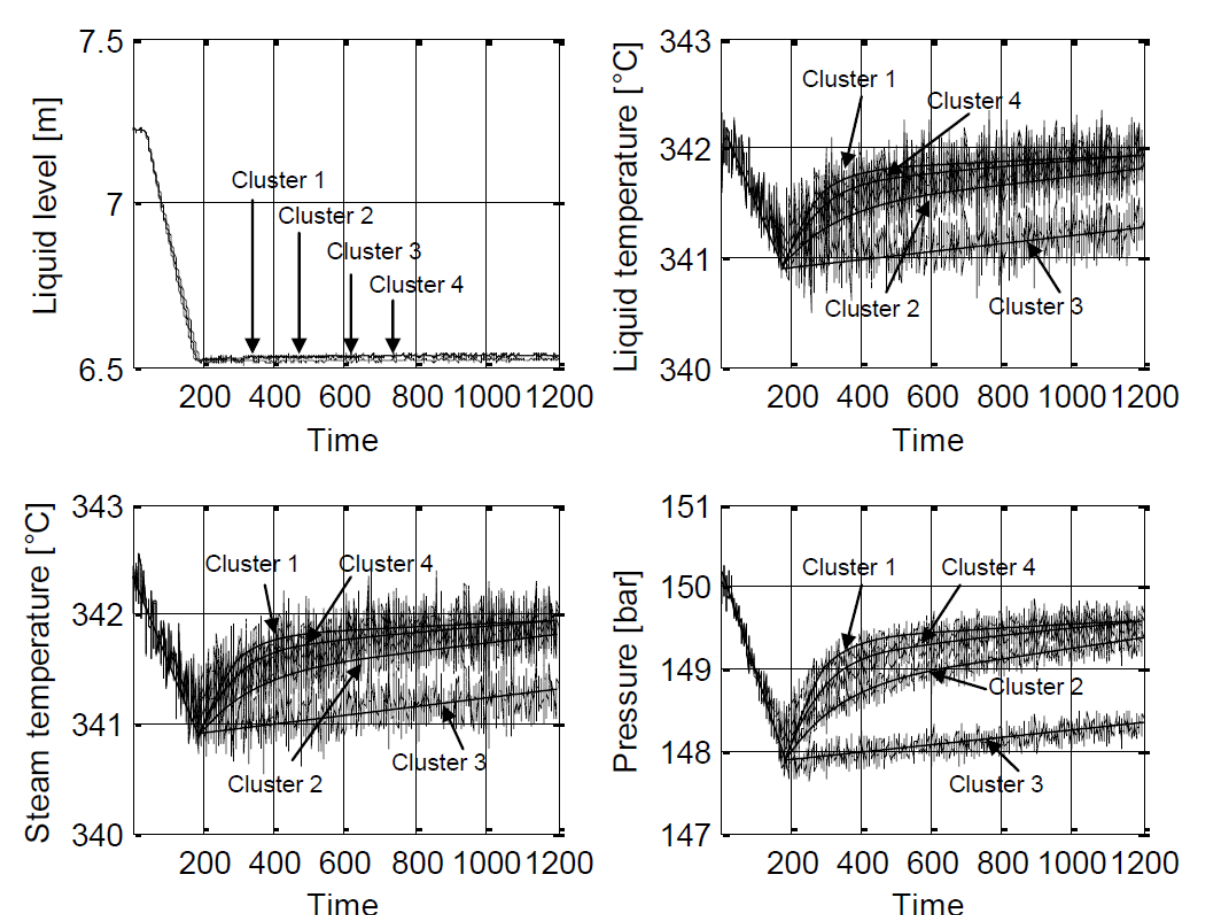
Fig. 22. Prototypical trajectories (noisy thin line) and filtered signals (smooth thick